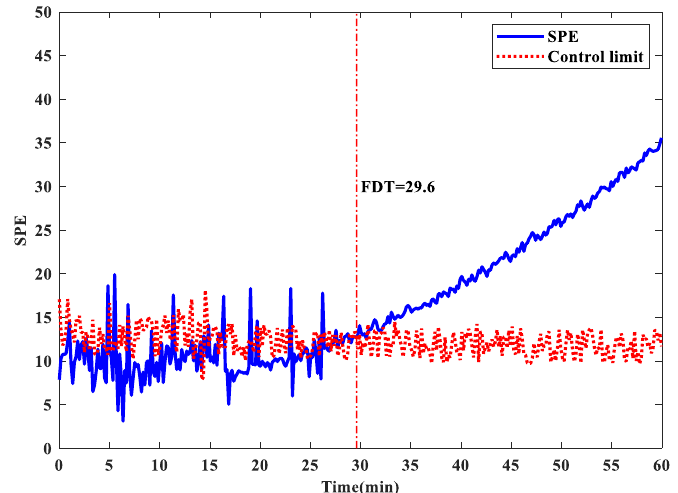
Figure 7. SPE fault monitoring chart of F4 based on MPCA.